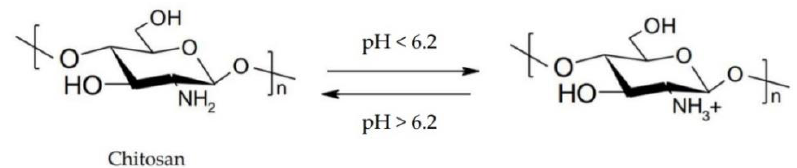
Figure 6. Schematic illustration of the protonation-deprotonation balance of chitosan.